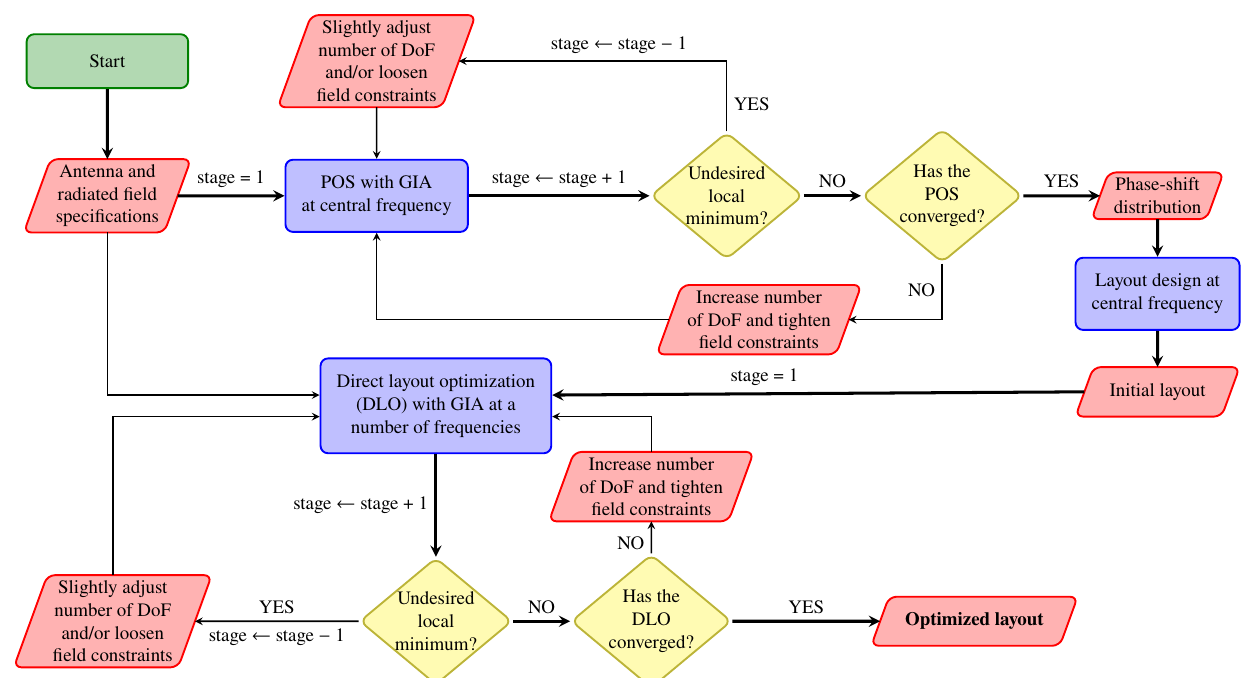
Figure 7. Proposed wideband optimization strategy for spatially fed arrays using the generalized intersection approach (GIA). First, a phase-only synthesis (POS) at central frequency is carried out in order to obtain a phase-shift distribution from which the initial layout is obtained. Then, the layout is used in a direct layout optimization (DLO) at multiple frequencies until specifications are